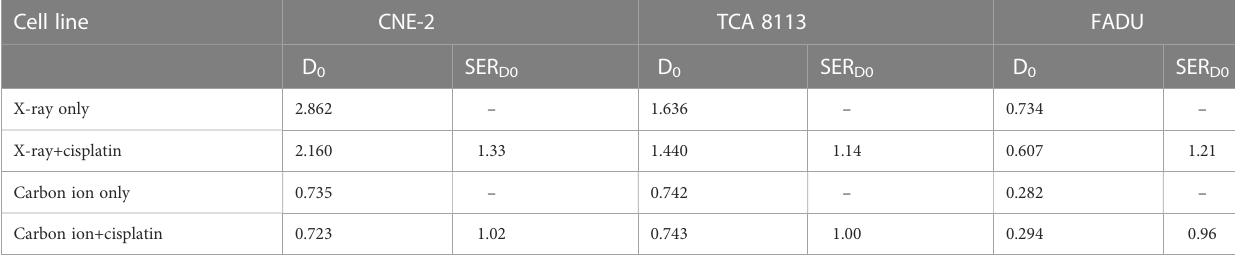
TABLE 3 SER D0 values of three HNSCC cell